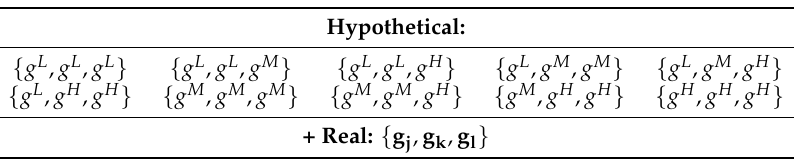
Table 1. Composition of contribution